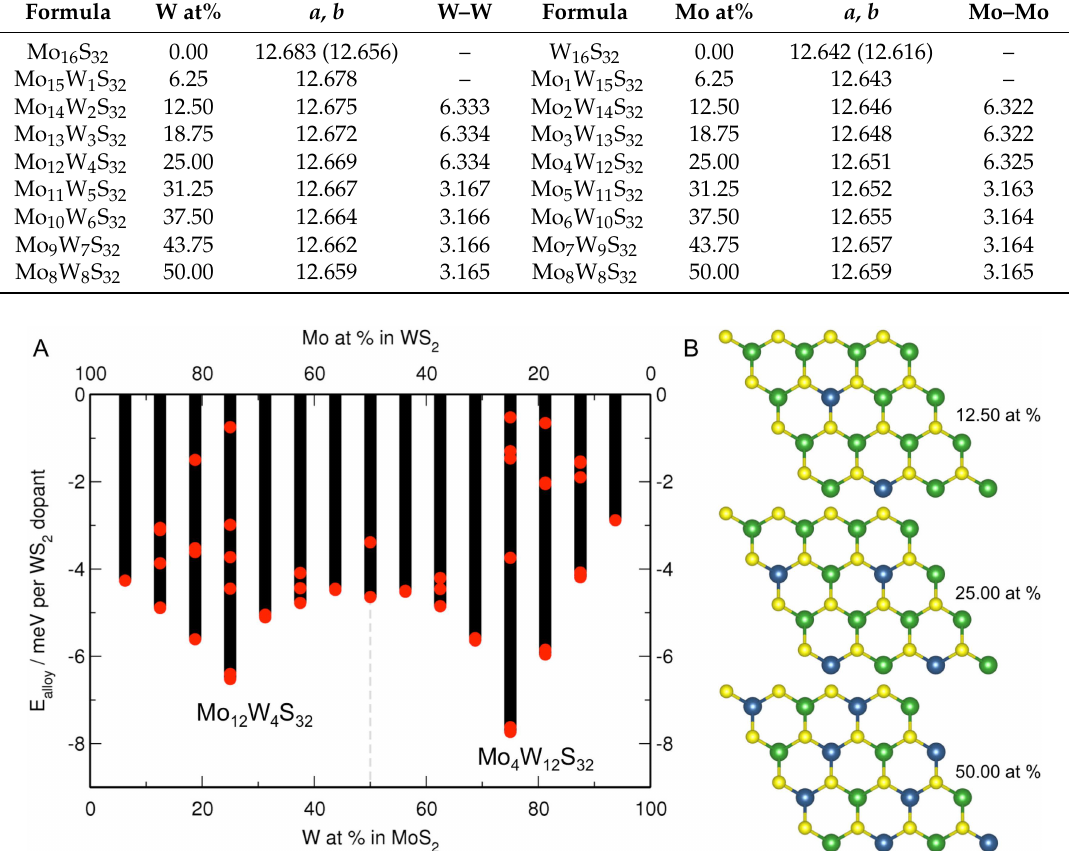
Figure 2. ( A ) Calculated alloying energies of Mo 1 ´ x W x S 2 systems ( x “ 0 ´ 1). Numbers calculated according to the Equation (2); ( B ) Selected alloys with the most stable W arrangement for a given concentration. Green, Mo; blue, W; yellow,